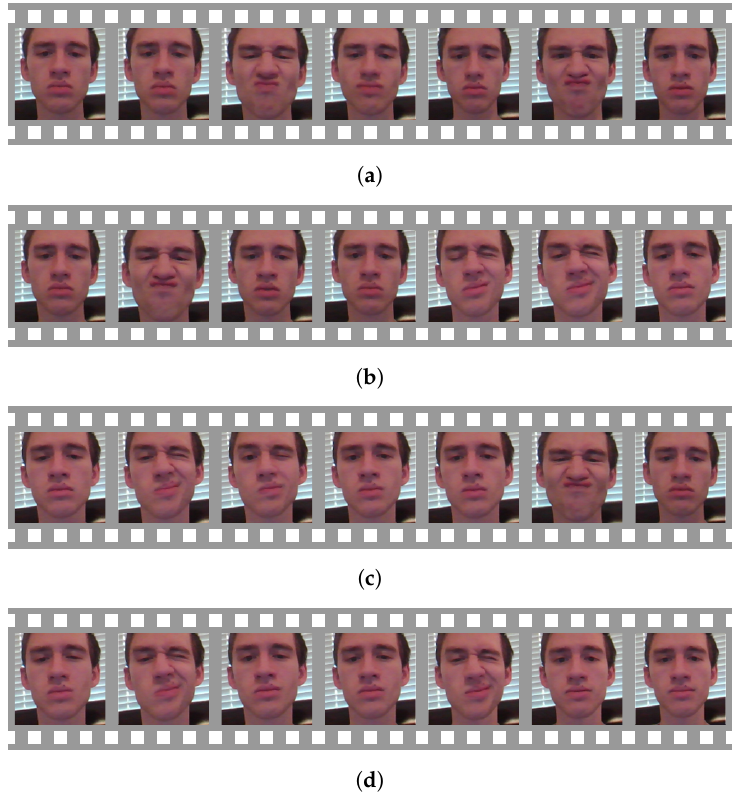
Figure 2. Clip examples in our compound facial action dataset. ( a , d ) have one type of facial action uttered twice, while ( b , c ) both contain two kinds of facial actions. These clips represent four different facial motions in our